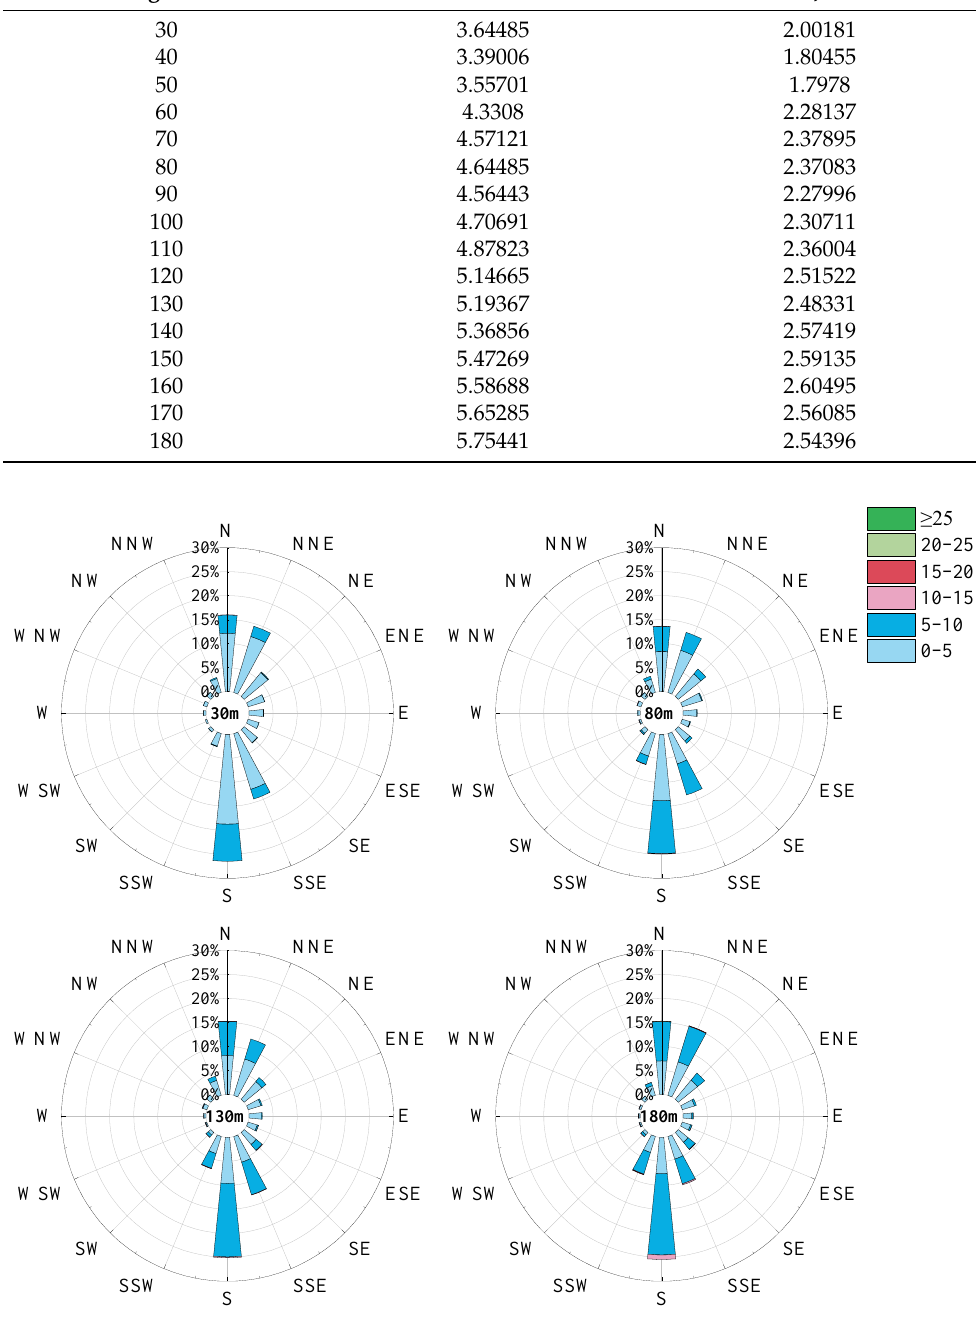
Table 5. Results and effects of each order fitting parameter at 30 m height.